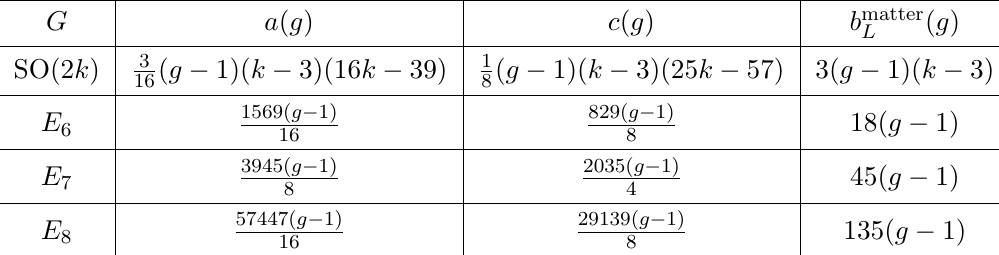
Table 8 . Values of a; c; b matter depending on the genus g , with no (cid:13)avor (cid:13)ux, l = L